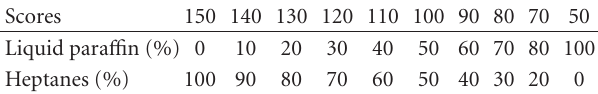
Table 1: Evalution standard of the oil repellency. Table 2: Durability of the finishing with di ff erent fire-retardant